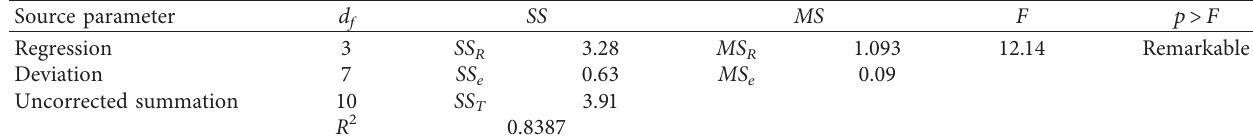
3 regression equation for the standard deviation of mixed cement and gravel